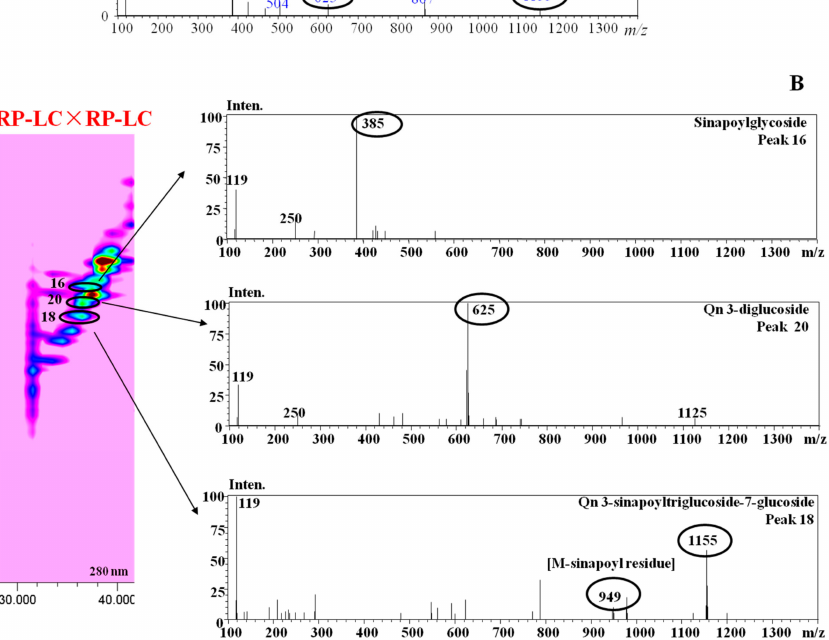
Figure 3. RP-LC ( A ) vs. RP-LC × RP-LC ( B ) analysis of metabolites in B. juncea cv. ISCI Top. Qn: